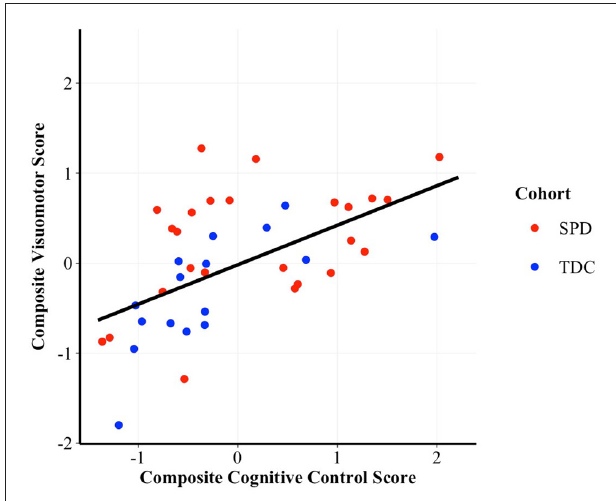
FIGURE 1 | Scatterplot of the correlation between cognitive control and visuomotor control composite scores. Higher scores are indicative of better performance. β = 0.41, p = 0.001. SPD, Sensory Processing Disorder; TDC, Typically Developing Controls.